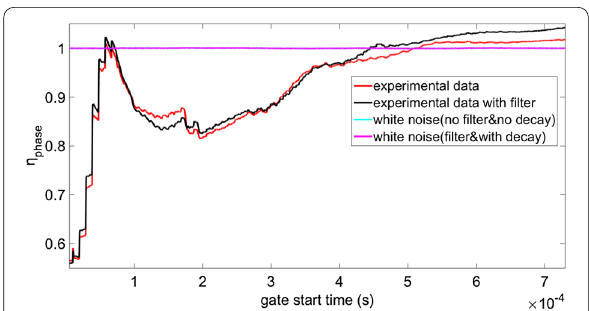
Figure 8 Diffuse field verification on white noise and experimental data using metric η phase